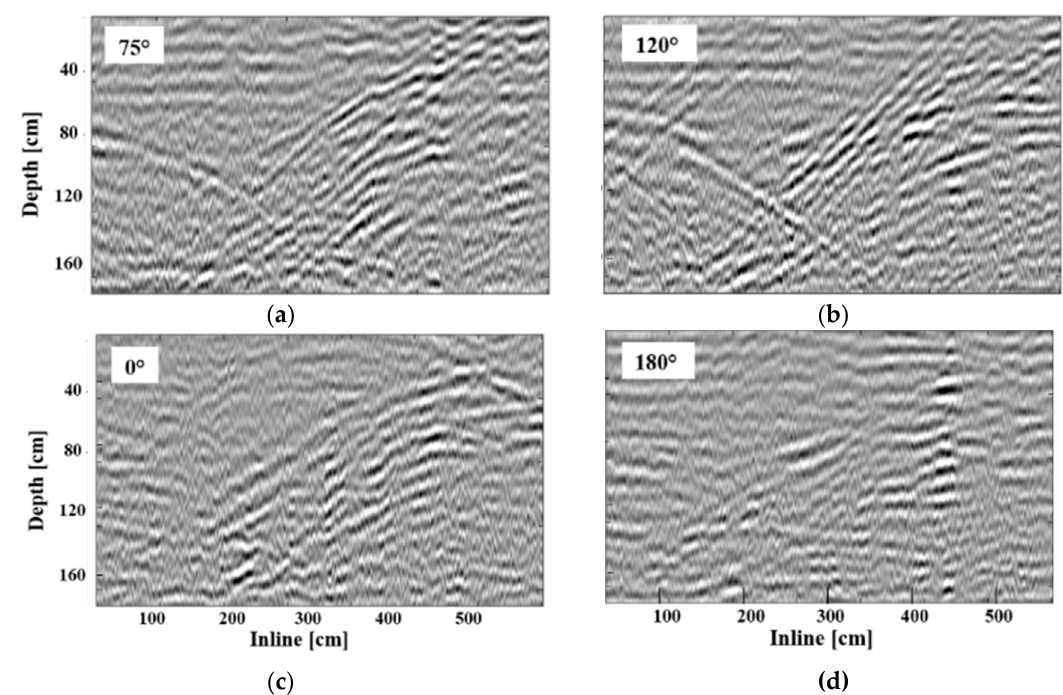
Figure 7. Highlight on fracture marked A: ( a ) Local maximum; ( b ) local minimum; ( c ) local maximum; and ( d ) local minimum.